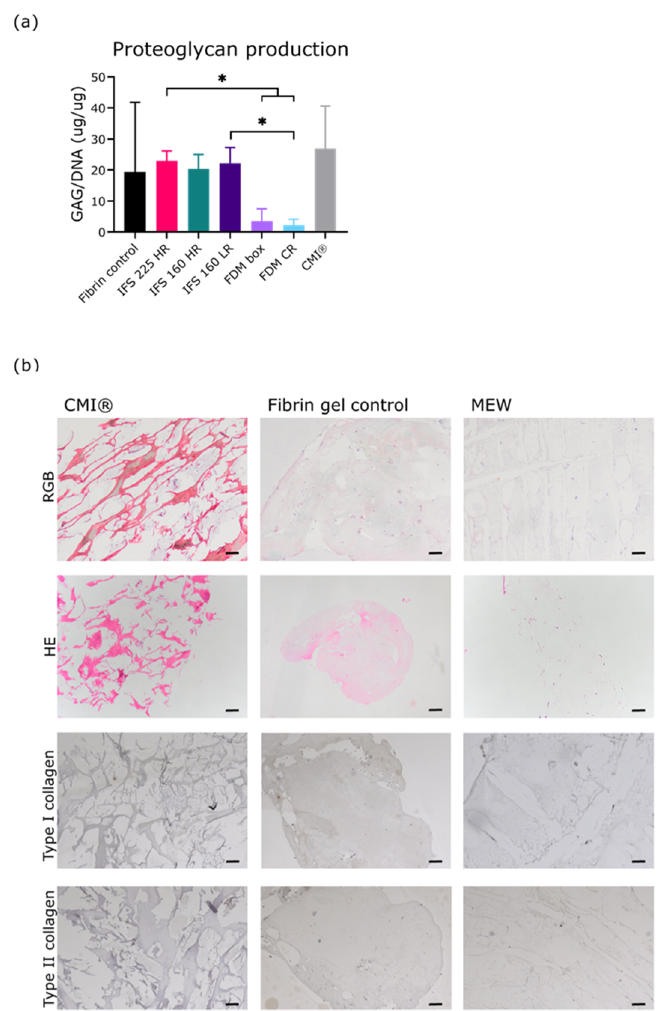
Figure 5. Cell distribution and extracellular matrix formation after 28 d of co-culture. ( a ) GAG production normalized for DNA content of scaffolds ( n = 3 donors, 3 technical replicates per donor). ( b ) Picrosirius Red, Fast Green and Alcian Blue (RGB), Hematoxylin and Eosin (HE), type I collagen and type II collagen stained sections showing cell distribution and tissue deposition in collagen meniscus implant (CMI), fibrin gel control, and melt electrowriting (MEW) scaffold after 28 d of culture( n = 3 donors, 2 technical replicates per donor. *, p < 0.05; 160: 160 µ m, 225: 225 µ m, Box: box-structure, CR: circumferential and radial fibres, FDM: fused deposition modelling, HR: high ratio of radial fibres, IFS: inter fibre spacing, LR: low ratio of radial